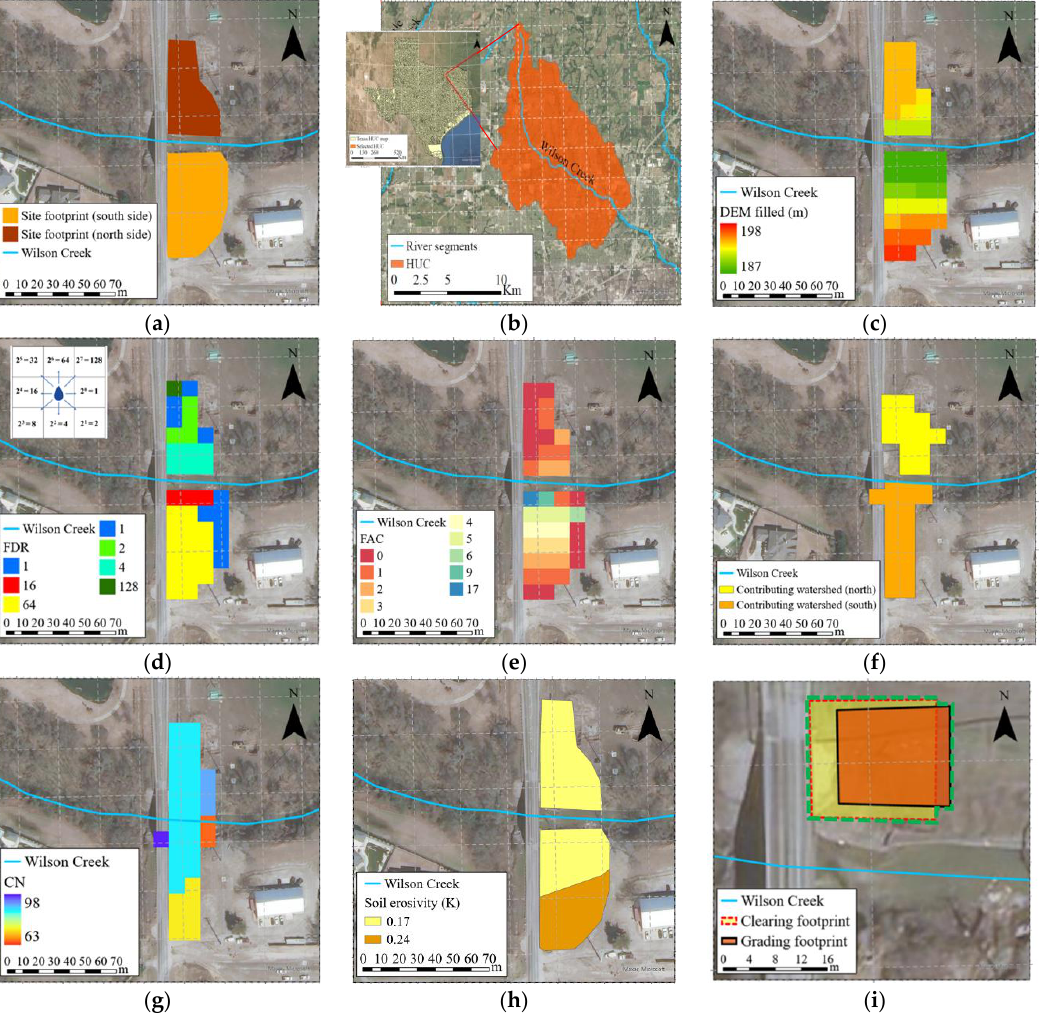
Figure 13. Wilson Creek ( a ) north and south bridge construction site footprints, ( b ) Texas HUC pieces used as repository dataset and selected watershed (HUC-12) for Wilson Creek by the model, ( c ) digital elevation model (DMF), ( d ) flow direction (FDR), and flow direction (FDR) values for eight different directions around a cell in raster dataset, ( e ) flow accumulation (FAC), ( f ) contributing watersheds, ( g ) curve number ( CN ), ( h ) soil erosivity factor ( K ), ( i ) footprint of clearing and grading activities in the north construction used in the calculation of weighted average soil erosivity factor ( K ).